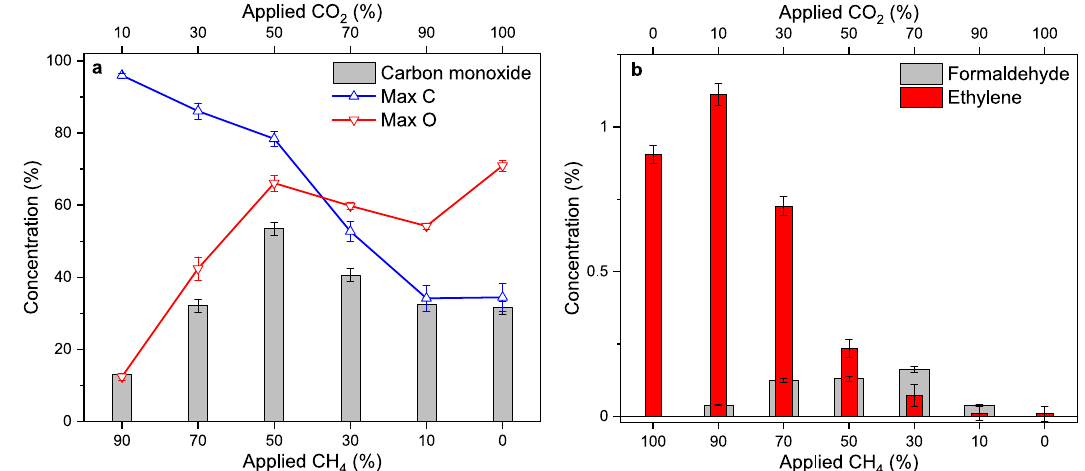
Figure 7. Retrieved concentrations of reaction products. ( a ) Measured CO concentrations for varying CH 4 / CO 2 ratio generated by the plasma (in grey). Maximum amount of carbon atoms (Max C, blue) and oxygen atoms (Max O, red), available from the CO 2 and CH 4 depletion in the discharge, indicate the maximum CO concentration that can be generated. The measured CO-levels are below these values. ( b ) Measured concentrations of ethylene (in red) and formaldehyde (in grey) generated by the plasma for varying ratios of CH 4 /CO 2